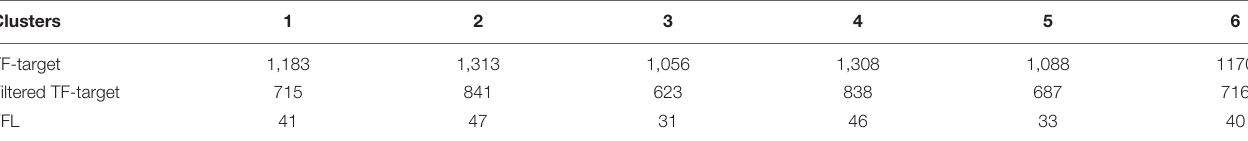
FIGURE 3 | Visualization of clusters using T-SNE. TABLE 2 | The number of regulation pairs in the cluster specific gene regulatory